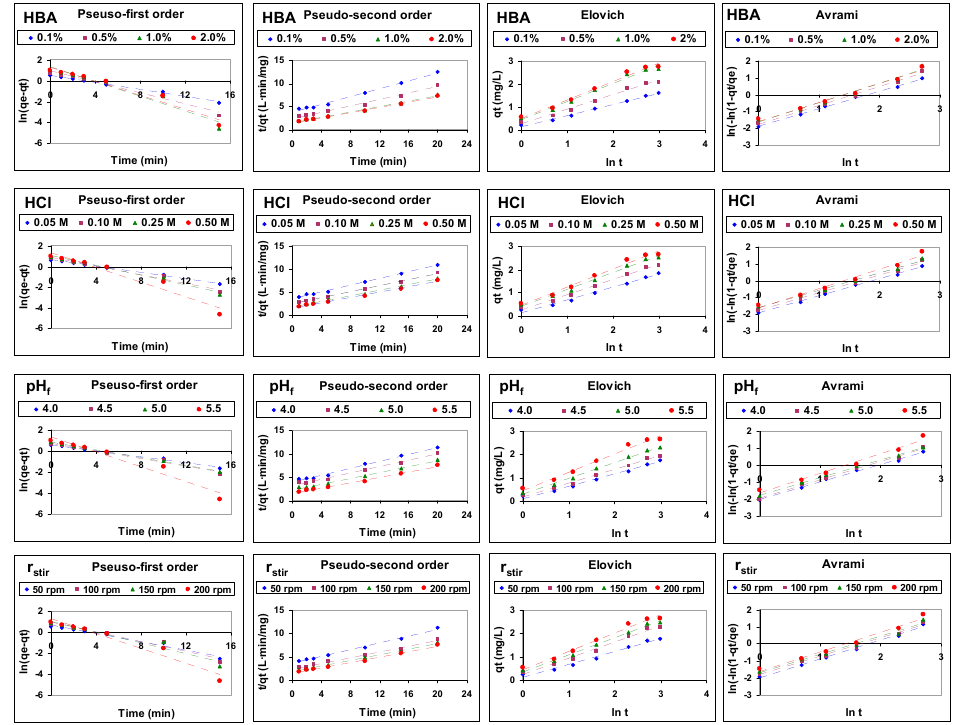
Figure 3. Fitting of the data obtained in the different experimental conditions to the studied kinetic models.